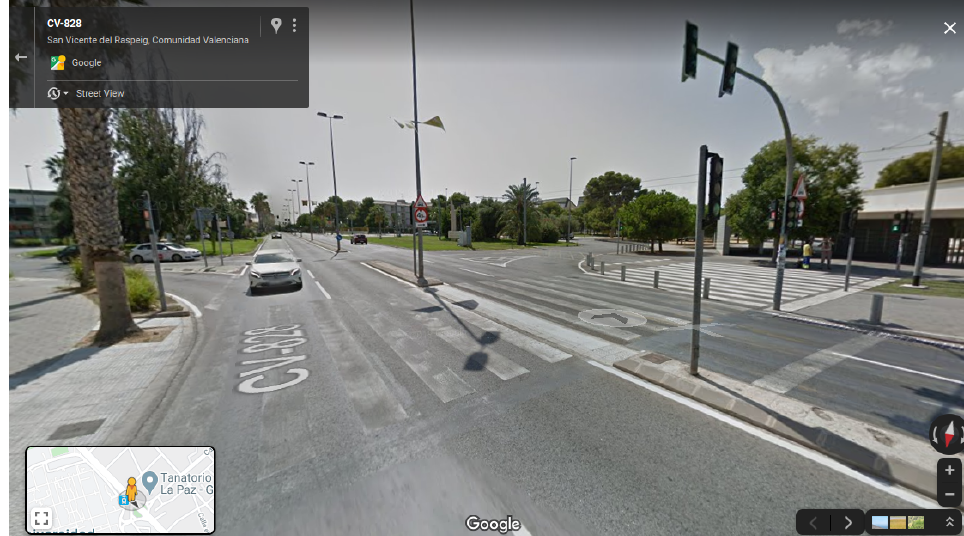
Figure 3. Google Street View image point of